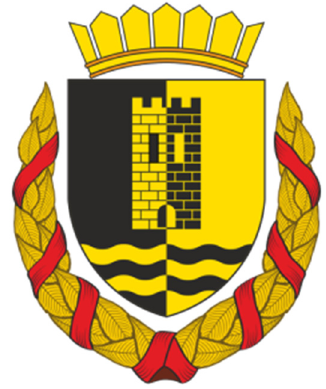
Figure 20. Palisade crown of Novo Selo.